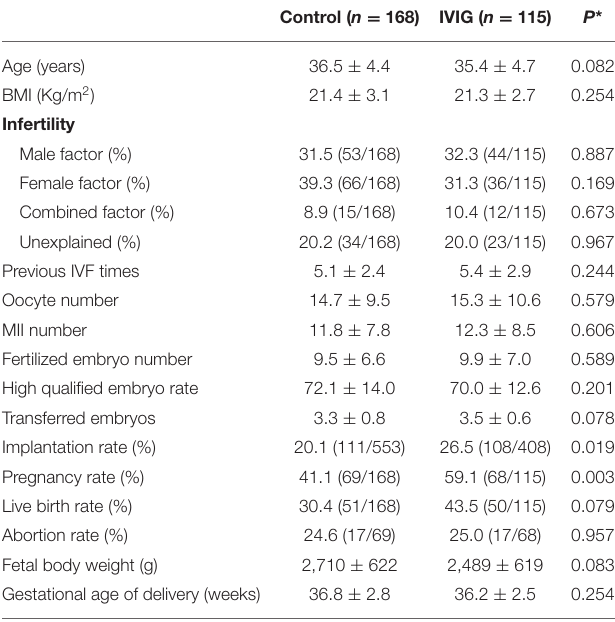
TABLE 1 | Demographic data of the control (Non-IVIG) and IVIG treatment groups.